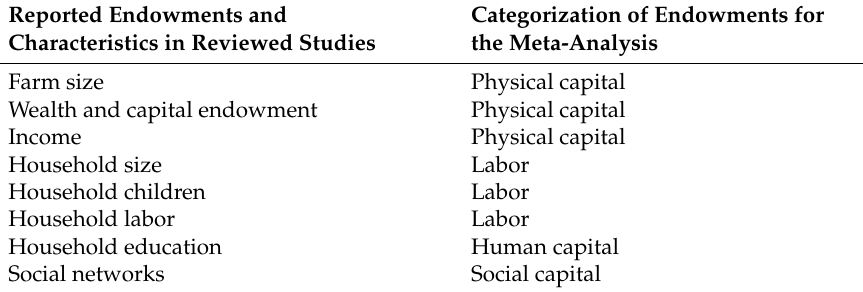
Table A3. Coding of reported